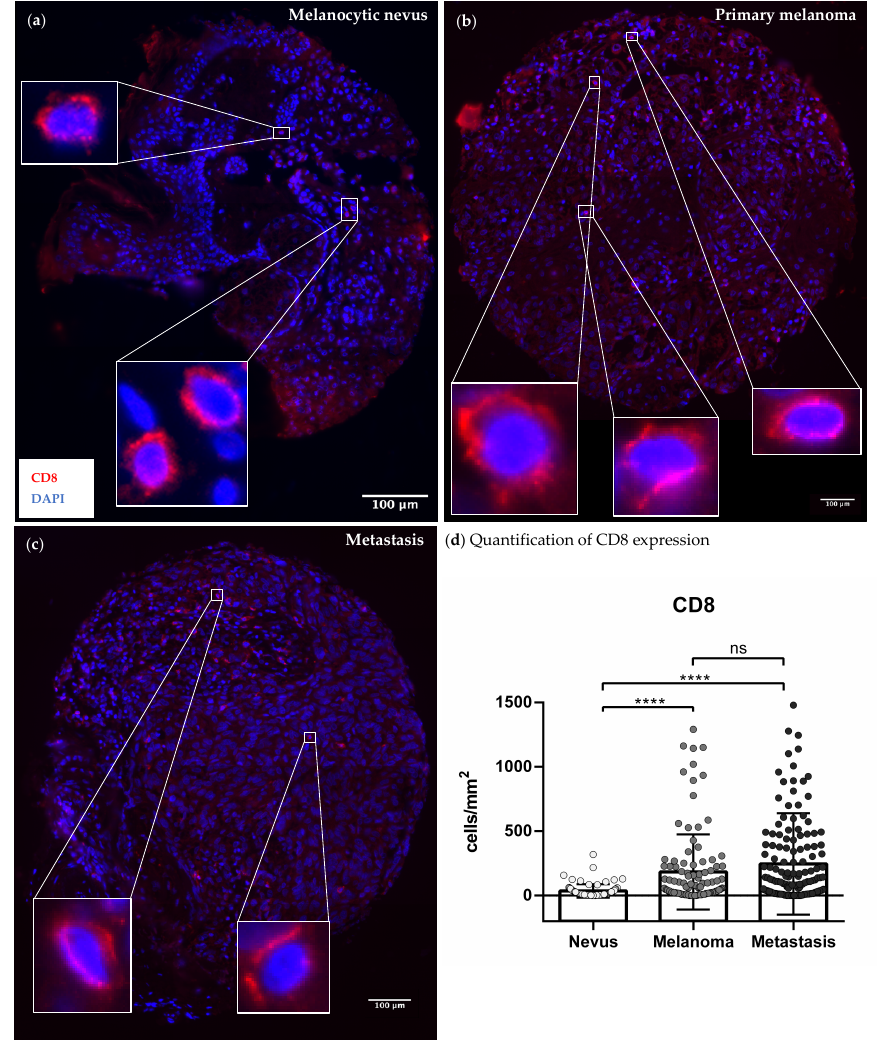
Figure 2. Representative expression patterns of CD8+ effector T-cells in human tumor tissue sections. Paraffin-embedded tissue samples of 77 melanocytic nevi, 108 primaries and 177 metastases from 118 melanoma patients were stained with immunofluorescent anti-CD8 antibodies (marked red). Nuclei were stained in blue with DAPI. ( a ) Exemplary image of a melanocytic nevi stained with anti-CD8 antibodies; ( b ) Exemplary image of a primary melanoma stained with anti-CD8 antibodies; ( c ) Exemplary image of an associated metastasis of melanoma stained with anti-CD8 antibodies; ( d ) Comparison of CD8 expression between nevi, primaries and metastases of melanoma patients. Abbreviations: CD: cluster of differentiation; DAPI = 4 (cid:48) ,6-Diamidin-2-phenylindol; ns: not significant; ****: p <